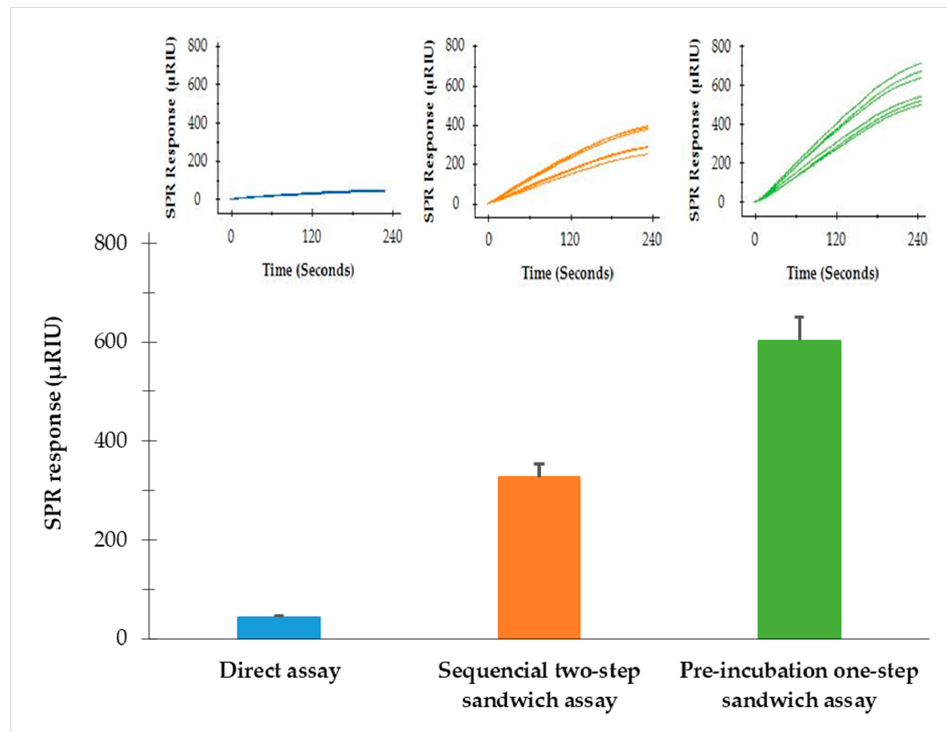
Figure 3. SPR responses at the peak of association phase of the three assay formats—direct assay, sequential two-step sandwich assay and preincubation one-step sandwich assay; same concentrations of flagellin extractions (9.2 µ g/mL) from S . Typhmurium were analyzed. Same concentration of MNPs (41.6 µ g/mL) was used in the sequential two-step sandwich assay and preincubation one-step sandwich assay. Two experiments were performed on different days, each with three